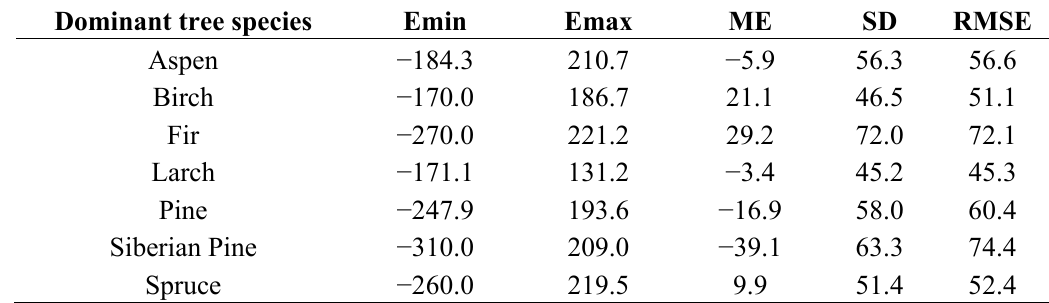
Table 5. Validation results, species-dependent statistics of the SAR and FI-based GSV comparison (m 3 /ha) for the multi-temporal